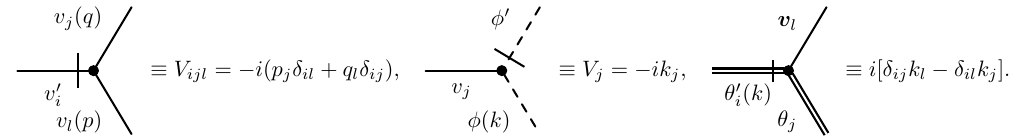
Figure 2. Graphical representation of all interaction vertices of the model given by the nonlinear part of the action